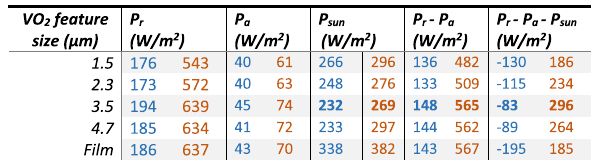
Table  : Calculatedterrestrial performancein radiationcoolingand solar power through at room temperature for VO  in cold (blue,  ° C), and hot (orange,  ° C) states.